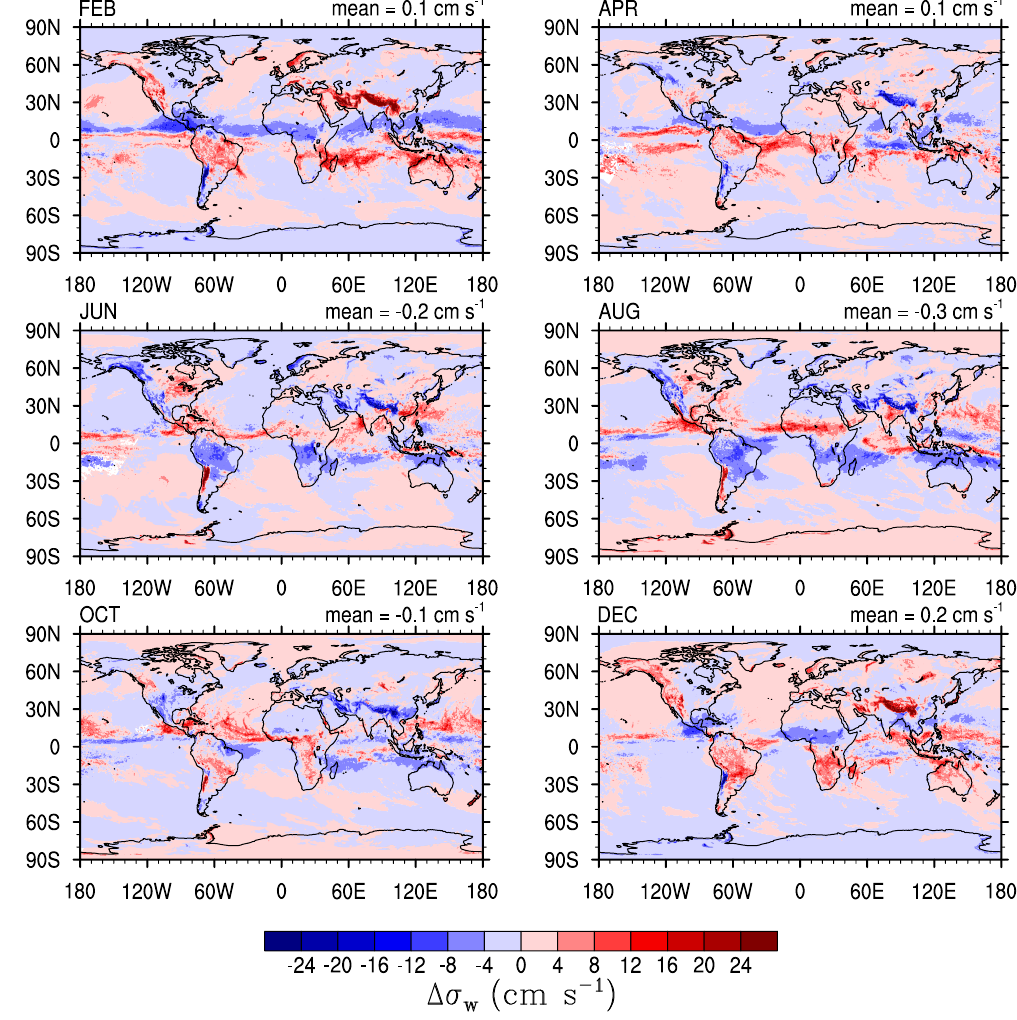
Figure 6. Difference between the monthly and annual σ w at 100 km resolution calculated from the G5NR 7 km resolution output at the 250 hPa pressure level. Maps generated using the NCAR Command Language (Version 6.3.0) Software. (2016). Boulder, Colorado: UCAR/NCAR/CISL/TDD.